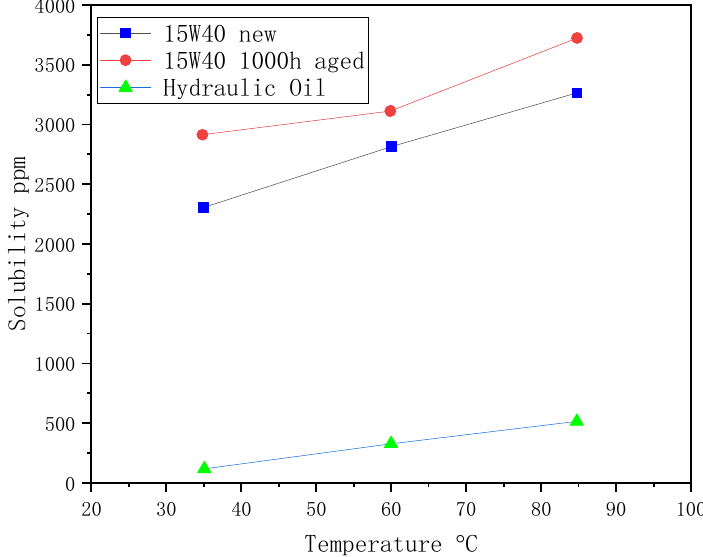
Figure 11. Water solubility in hydraulic and engine oil measured by a water content sensor. Water in oil is typically measured in the laboratory with Karl Fisher titration (ISO12937 or ASTM D1533). The Karl Fisher method measures total absolute water in ppm with high accuracy. However, this method is not totally appropriate with engine oil because the measurement could be impacted by specific engine oil additives. The Aqua test (ISO/DIS 9114 or ASTM D7358) and FTIR spectroscopy (ASTM D7418) are alternative methods for measuring total absolute water down to 100 ppm and with 100 ppm accuracy. These